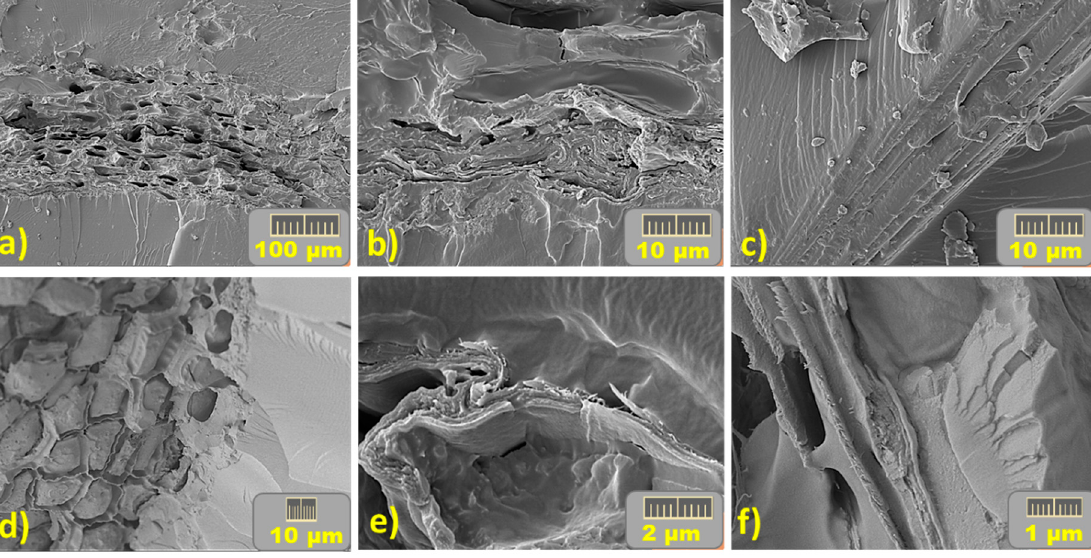
Figure 10. SEM micrograph of the ELO-based formulations filled with SB at ( a ) 100 µm, ( b – d ) 10 µm, ( e ) 2 µm, and ( f ) 1 µm.